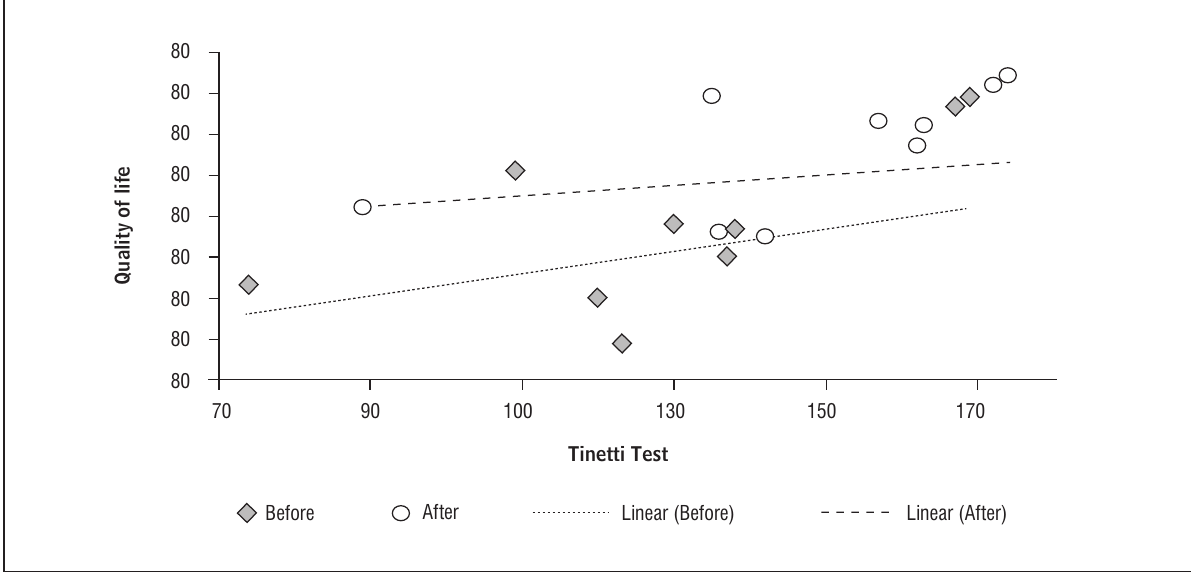
Figure 5 - Correlation between QOL and Tinetti test, before and after whole body vibration treatment Note: r = 0.699, p = 0.024 (before) and r = 0.729, p = 0.016 (after). Source: Research